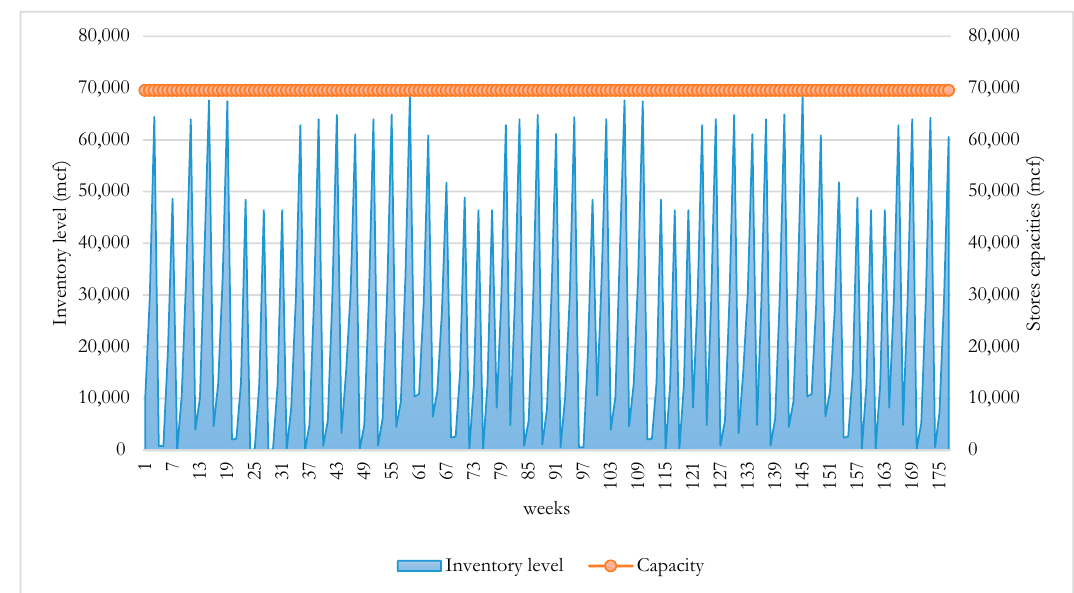
Figure 7 indicates the fractionation plant storage capacities and inventory levels fluctuations across the planning horizon. Production and maintenance are carried out on a weekly basis, while demand is on a monthly basis. As a result, the inventory level accumulated over the first four weeks of a month, then decreased as demand occurred at the end of the last week of a month.